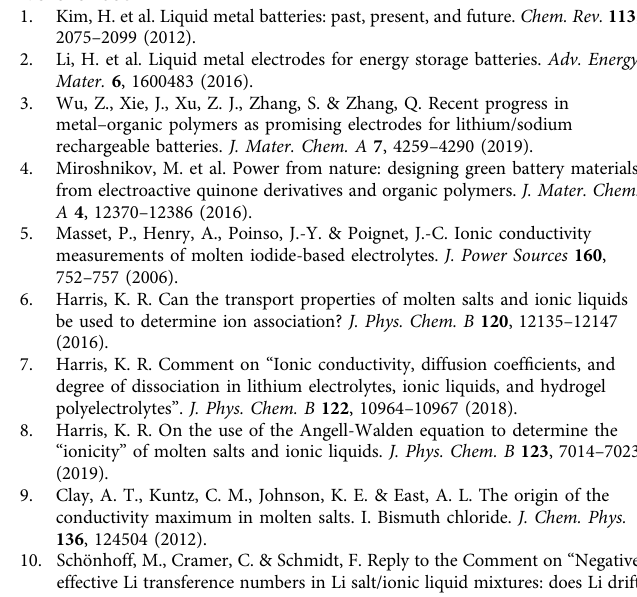
Supplementary Note 4: a table listing mobilities and partial conductivities, the parametric expression to approximate the conductivity data, a table comparing simulated vs. calculated conductivity, and transference numbers; Supplementary Note 5: radial distribution functions (cation – anion); Supplementary Note 6: details on the evaluation of bond distances, CNs, lifetimes, and Gibbs free energy of activation of bond breaking; and Supplementary Note 7: ternary plots of the experimental melting points and conductivities. Furthermore, two Supplementary Movies are provided. Both movies show the movement of selected ions in molten LiF-LiCl-LiI eut at 1200K with an